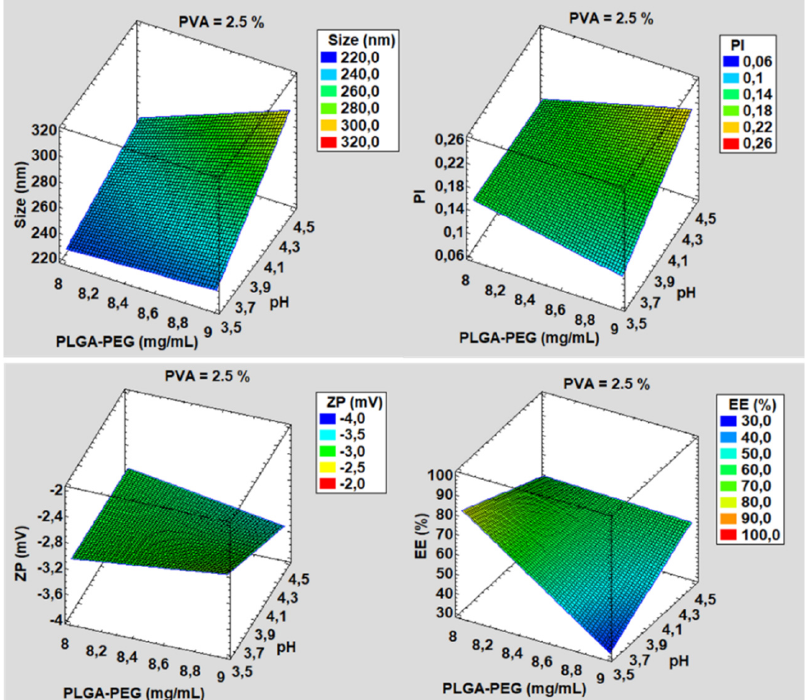
Figure 1. Surface response of PGZ-NPs developed by factorial design before the spray drying process. PVA=2.5%. pH and PLGA ‐ PEG concentration influence on the size, PI, ZP and EE % of NPs. After that, the experiment using the Nano Spray Dryer B ‐ 90 was carried out with this particular formulation. From here, four PGZ ‐ NPs were obtained with different spray con ‐ ditions (see Section 2.4). Parameters such as size, PI, ZP and EE % were determined (Table 2). The particles showed a slight decrease in the surface charge after spraying as well as a slight increase in mean particle size. Moreover, size and surface morphology of the selected PGZ ‐ NPs were determined by TEM (Figure 2), evidencing that PGZ ‐ NPs were morphologically spherical and pre ‐ sented low dispersion. In addition, after the spray drying process, TEM (Figure 3) and SEM (Supplementary Materials, Figure S1) determinations were performed in order to en ‐ sure the drying process did not change the morphology of the particles. SEM images of NP ‐ based dried solids showed a high polydispersity of the aggregates present in the powder, from nanometers to micrometers in diameter. This is the usual phenomenon when using the spray drying technology to dry this type of suspension [64]. After the resuspension of the NP ‐ based dry solids in water (Figure S1), it was possible to observe an acceptable polydispersity (PI 0.24) that was correlated with DLS measure ‐ ments (Table 2). Figure 2. TEM images of PGZ ‐ NPs in suspension before spray drying.